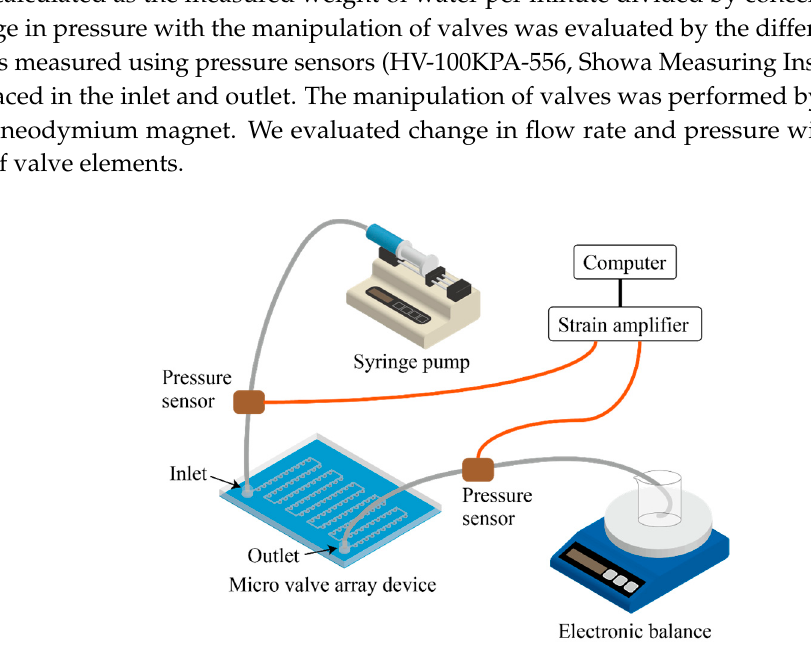
( b ) Figure 6. Evaluation of diffusion of magnetic particles in photosensitive composite: ( a ) Cluster area, and ( b ) number of clusters with respect to the change in weight ratio of magnetic particles.